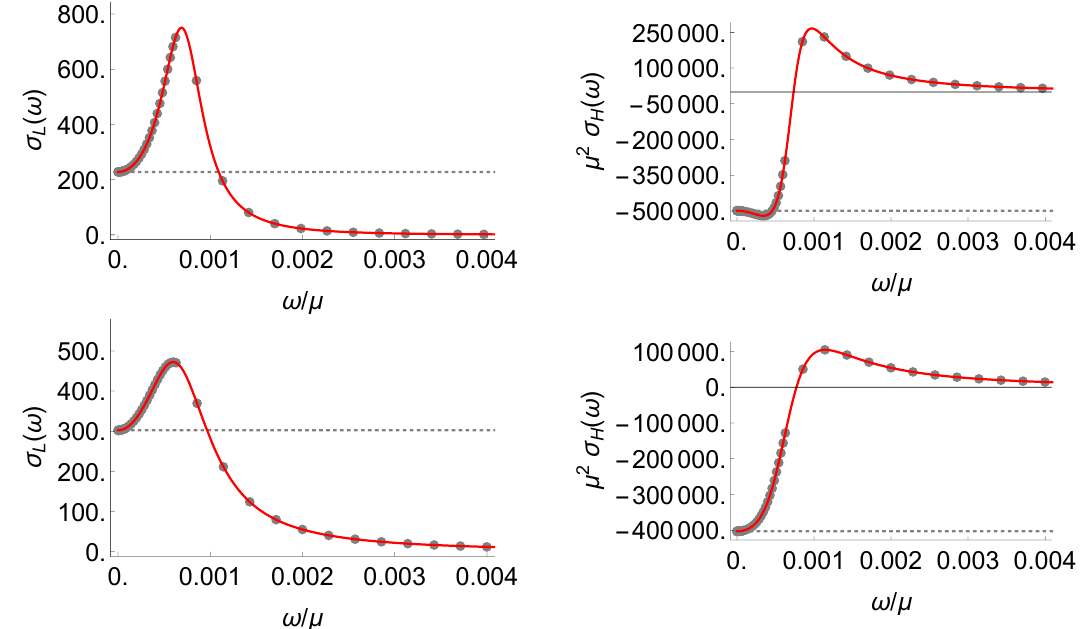
Figure 4. AC electric conductivities at B/µ 2 = 10 − 3 , T/µ = 10 − 1 and k/µ = 10 − 1 . Red lines are the analytic hydrodynamic expressions while grey dots are numerical data. Left: the longitudinal conductivities in two regimes - the pseudo-spontaneous (top) where λµ/φ v ≈ 0 . 004 and a strongly explicit regime (bottom) where λµ/φ v ≈ 0 . 95 . In both cases our hydrodynamic expressions closely match the data. Right: the Hall conductivities in the same